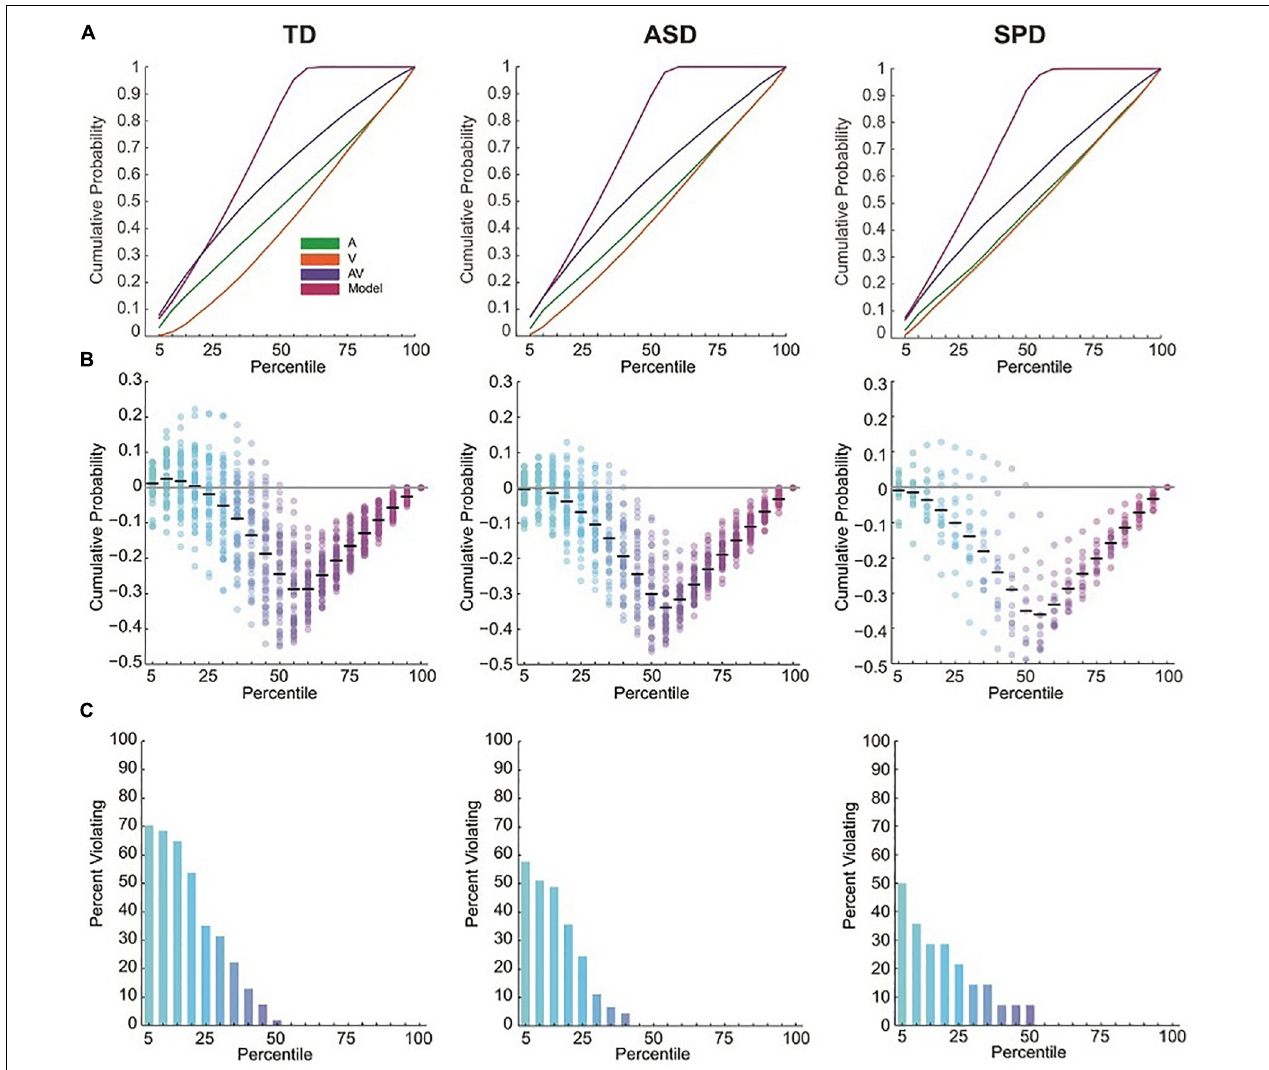
FIGURE 2 | RT cumulative probability distributions and miller inequalities. (A) RT cumulative probability for each of the three stimulus conditions and the Race Model. (B) Miller inequalities. Semi-opaque circles represent individual participants. Black horizontal bars are the mean across participants at each percentile. (C) Percent of participants violating the Race Model at each